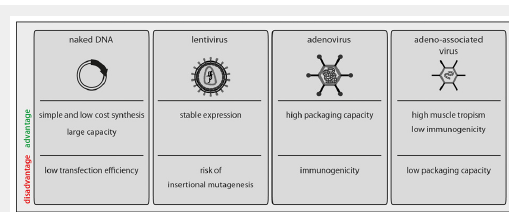
Different gene therapy strategies used in muscular dystrophies. In muscular dystrophies, gene therapy is used to deliver genetic material into the host and finally target the diseased muscle tissue to correct the genetic defect. In most cases, the transferred DNA encodes for the protein missing due to a mutation. Gene transfer can be mediated by different strategies and vectors. The methods differ in their transduction efficiency, packaging capacity, risk of immunogenicity or oncogene activation by genome